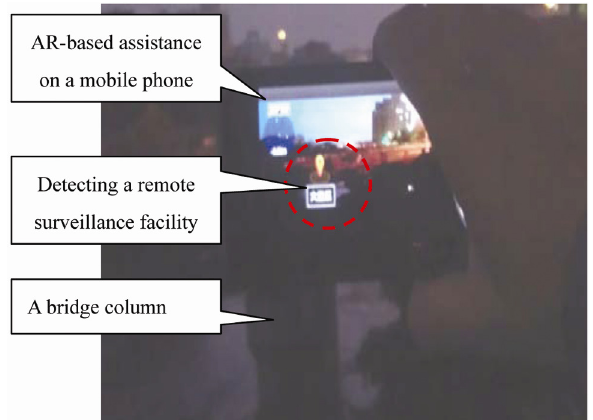
Fig. 6. Using AR-based assistance on disaster sites at night